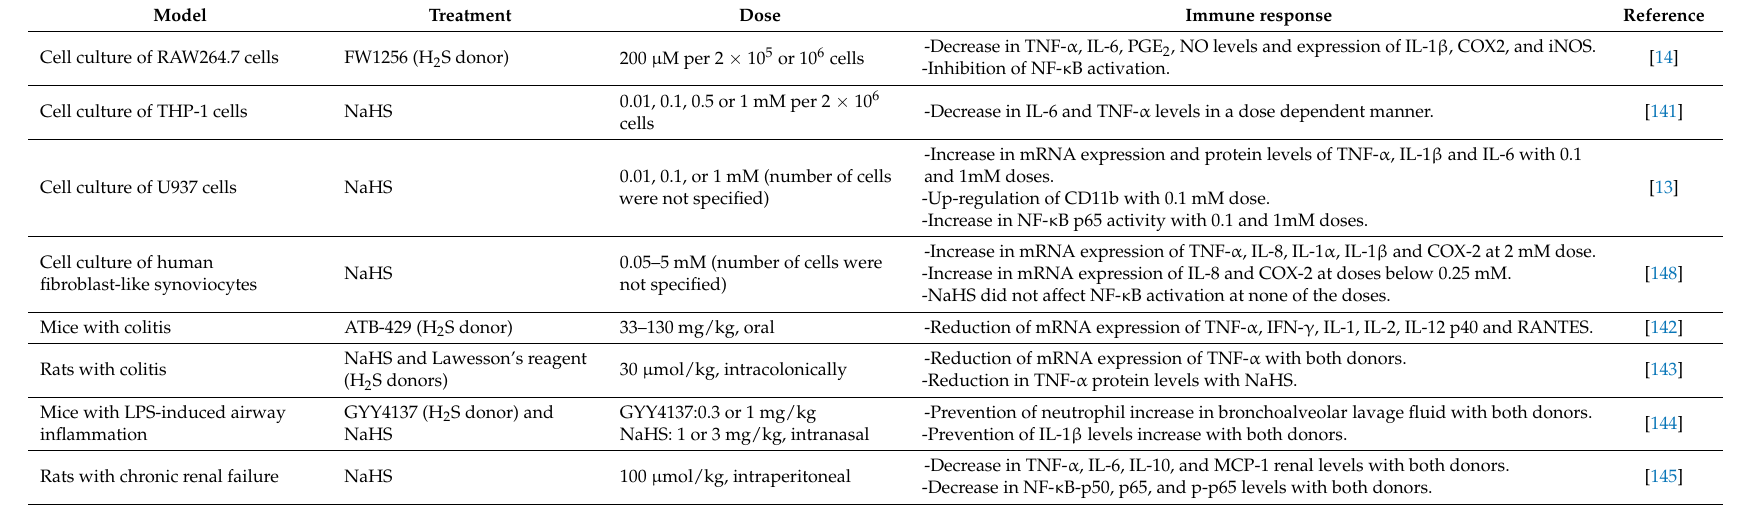
Table 3. Previous studies on the effect of hydrogen sulfide on